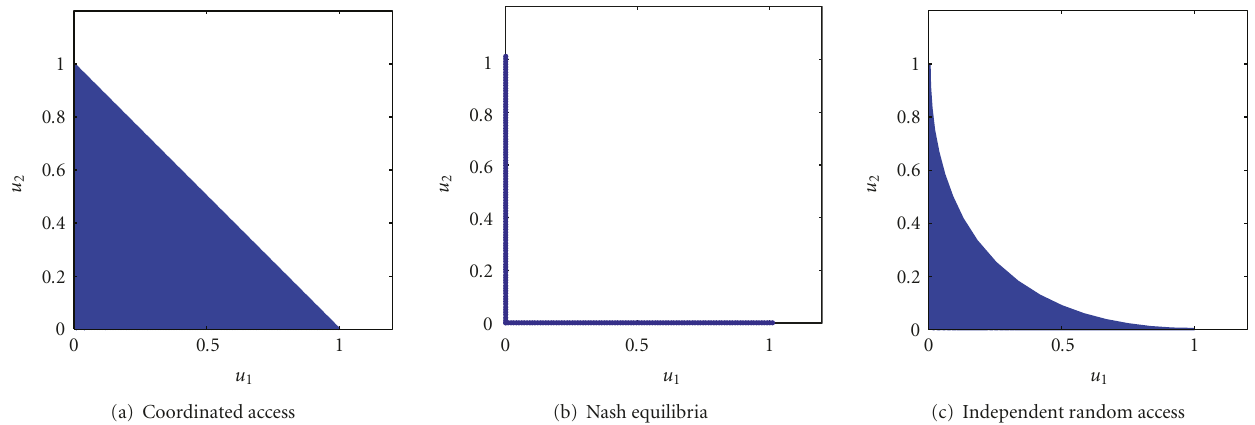
Figure 1: Payo ff profiles with two homogeneous users with k 1 = k 2 = 1. (a) The set of feasible payo ff s when coordination between two users is possible. (b) The set of Nash equilibrium payo ff s. (c) The set of feasible payo ff s with independent transmission